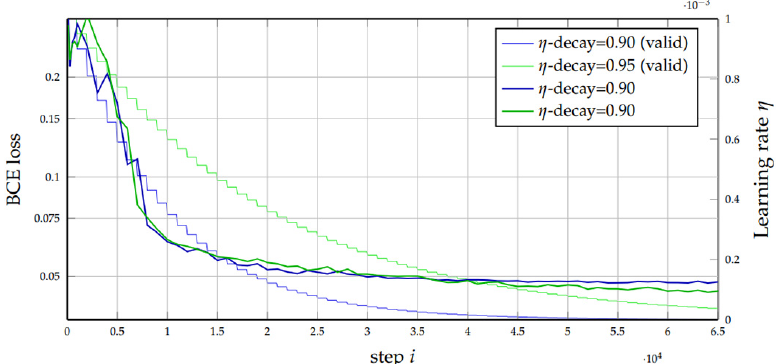
Fig. 11. Validation losses of two identical network models using different learning